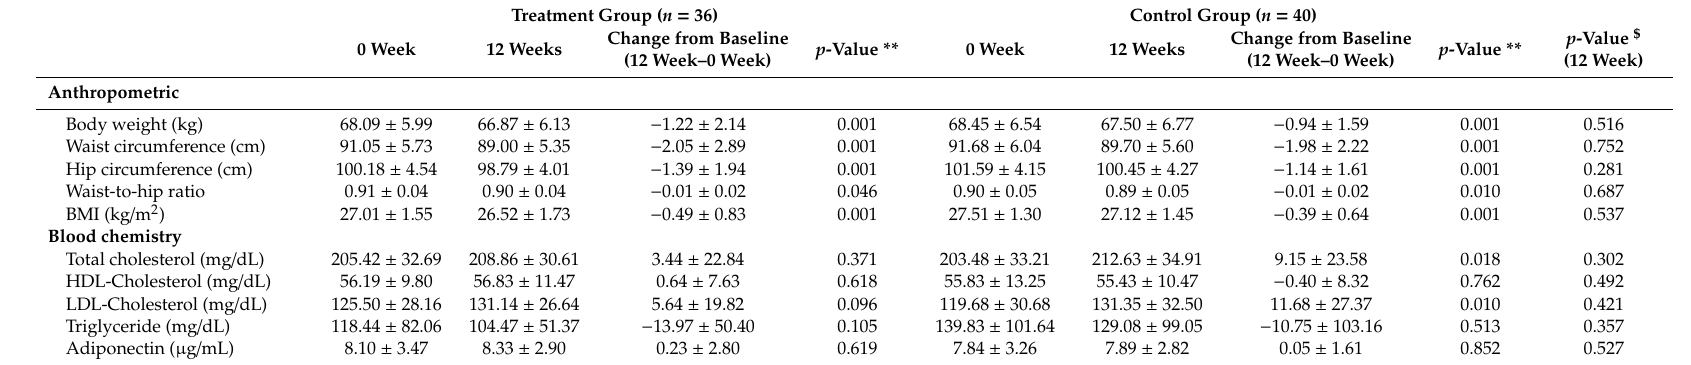
Table 3. Anthropometric and blood chemistry analysis of 12-week treatment (COEC) and control (placebo) group.